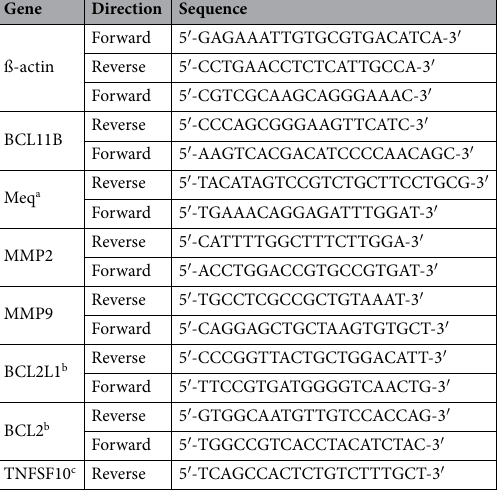
Table 1. Primers for genes used for qPCR. a Primer is from Heidari et al . (2008) 55 ; b Primer is from Subramaniam et al . (2013) 56 ; c Primer is from Li et al . (2008) 57